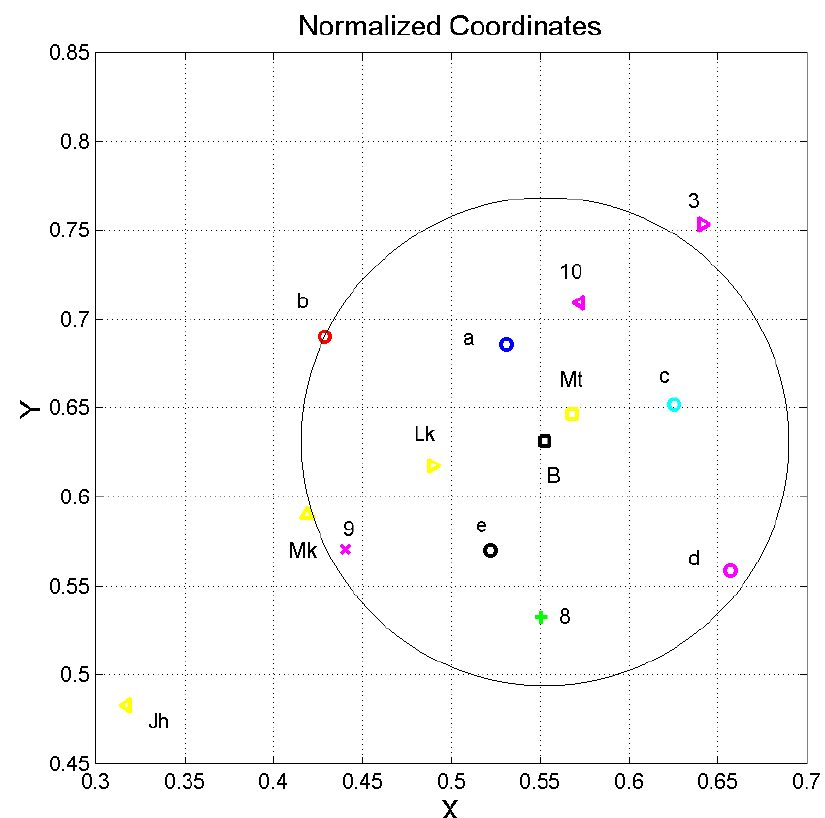
Figure 9. Normalized coordinates x and y of the resulting vector (18) of the literary works listed in Tables 1 and 2 (detail) and the canonical Gospels ( Matthew , Mark , Luke , John , yellow marks), normalized so that Of Mice and Men is located at the origin (0,0) and Moby Dick is located at (1,1). Dickens’ novels are represented by the circles: The Adventures of Oliver Twist , a , blue; David Copperfield , b , red; Bleak House , d , magenta; A Tale of Two Cities , c , cyan; Our Mutual Friend , e , black. The other novels are numbered according to the order reported in Table 2. Table 12. Gospels statistics, King James version. Number of chapters (i.e., the number of samples considered in calculating the regression lines of the theory), total number of characters contained in the words, total number of words and sentences, deep language parameters 𝐶 𝑃 , 𝑃 𝐹 , 𝐼 𝑃 , 𝑀 𝐹 , with standard deviation reported in the second line.